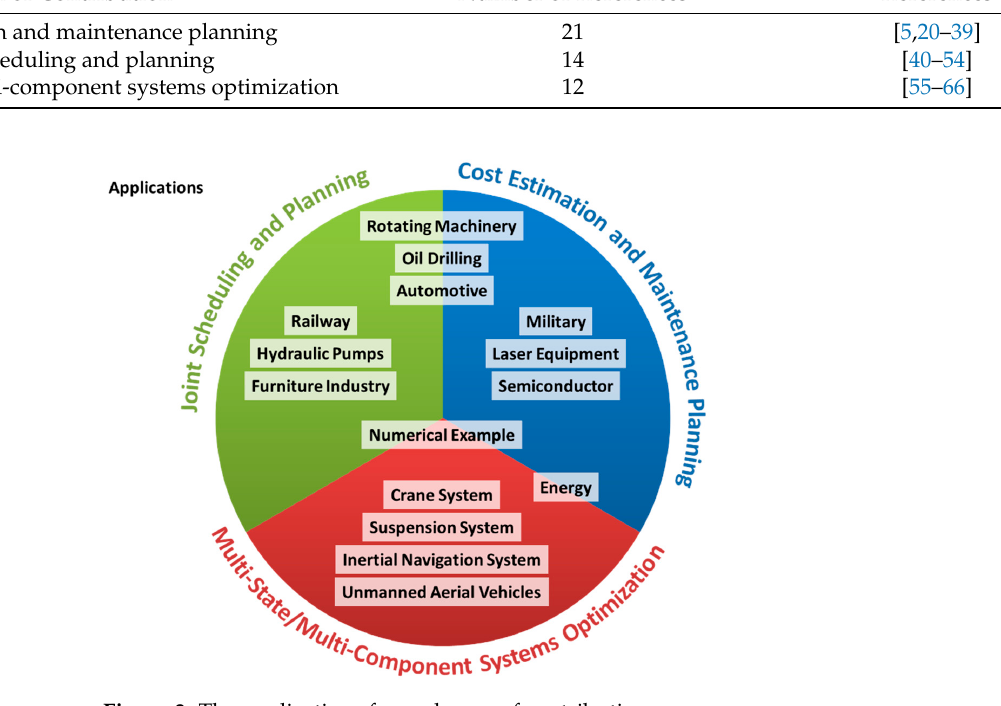
Figure 3. The applications for each area of contribution.